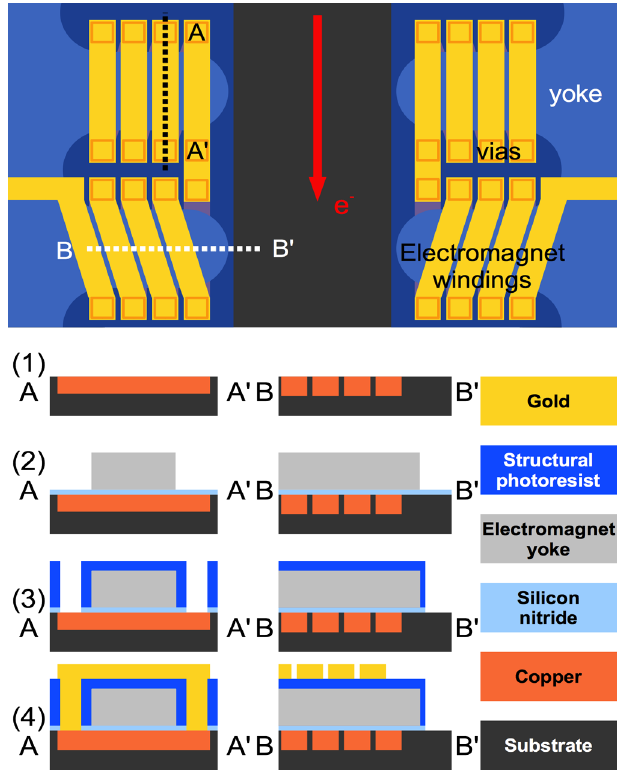
FIG. 11. Microelectromagnet device fabrication process. Film thicknesses are not to scale.